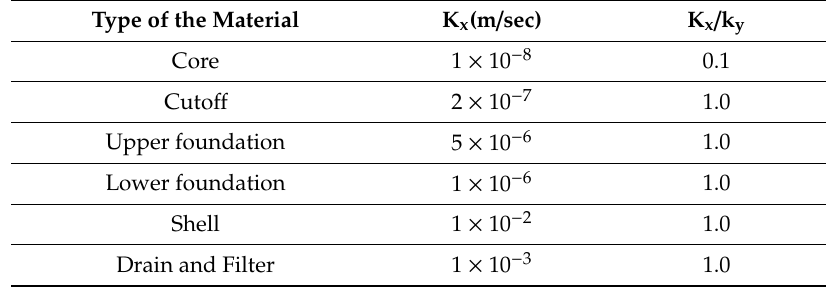
Table 1. The permeability of the materials used in the components of the dam.